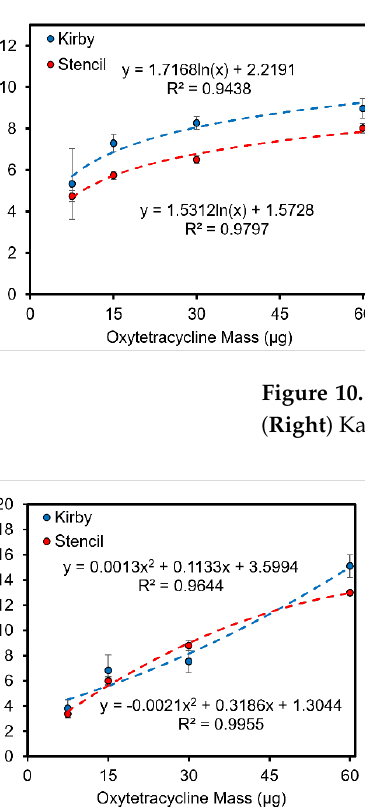
Figure 11. X. alfalfae . Plant Bacteria Antibiotic Resistance Test. ( Left ) Oxytetracycline, ( Center ) Strep- tomycin, ( Right ) Kanamycin.